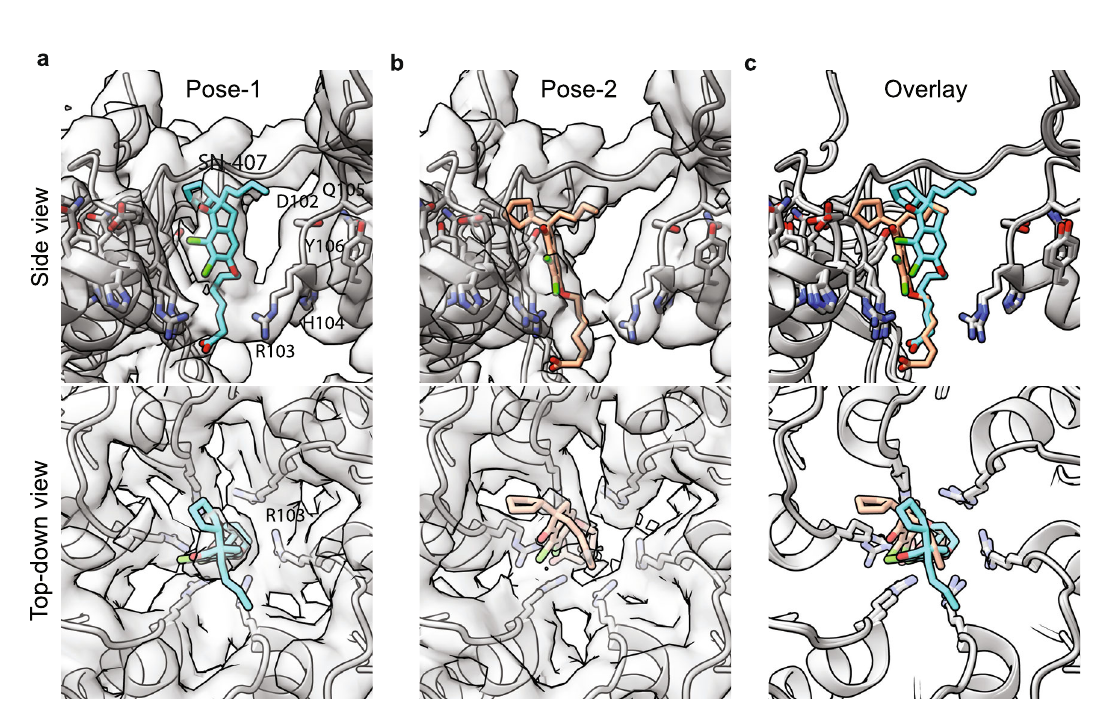
Fig. 7 Cryo-EM of SN-407-SWELL1 complex. a – c Cryo-EM images revealing: Pose-1 ( a ), Pose-2 ( b ), and overlay of Pose 1 and 2 ( c ) views of selectivity fi lter with SN-407 bound from the membrane plane (side view) and top-down view. The atomic model is represented as ribbons and sticks within the cryo- EM density with three subunits removed in the side view for clarity. Cryo-EM density is represented in transparent gray, nitrogens are colored blue, oxygens red, chlorines green, protein carbons gray, and SN-407 carbons teal (Pose1) or orange